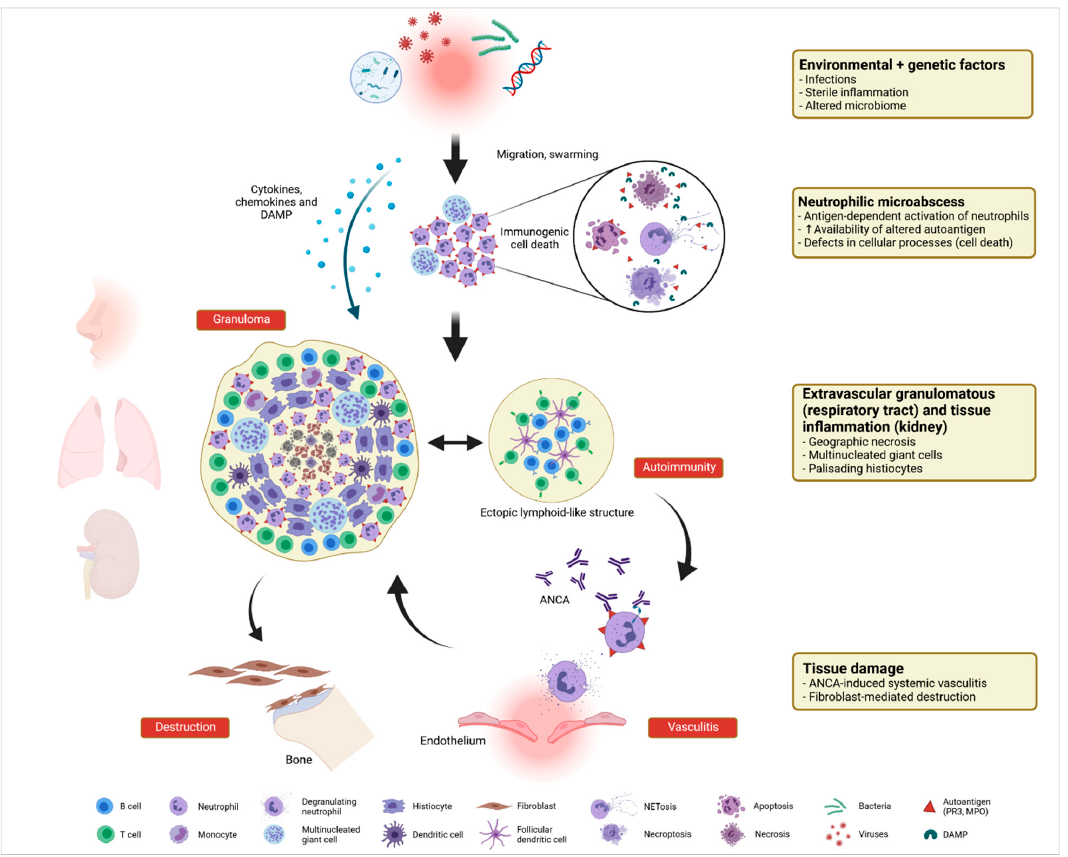
Figure 3. Development and function of the granulomatous inflammation in GPA. A combination of predisposing genetic factors as well as exogenous and endogenous immune-stimulatory patterns such as infections, altered microbiome, and sterile inflammation serve as initial trigger for the recruitment and activation of extravascular primed neutrophils forming neutrophil-rich microabscesses. Appearance of multinucleated giant cells (MGC) in close proximity represents a primary granulomatous feature of this early stage of the granulomatous lesion. Immunogenic cell death (dysregulated apoptosis, necrosis, necroptosis, NETosis) leads to the release of damage-associated molecular patterns (DAMP) and contributes to increased availability of the (altered) autoantigen proteinase 3 (PR3). Concomitant pro-inflammatory cytokines and chemokines drive recruitment of further immune cells, converting the neutrophil-rich necrotizing lesion to a monocyte/macrophage-rich granuloma. Palisading histiocytes around a necrotic zone, accompanied by MGC and the accumulation of monocytes, as well as lymphocytes, define the characteristic histological feature seen in the respiratory tract and the kidney. Occurrence of inflammation-related ectopic lymphoid structures (ELS) set the prerequisite for the loss of tolerance against the autoantigen PR3 that is continuously displayed by high numbers of neutrophils and monocytes within the granulomatous lesion. Tissue damage occurs as result of ANCA-induced systemic vasculitis and inflammation- and fibroblast-mediated local destruction of cartilaginous and osseous tissues in the upper respiratory tract. Created with BioRender.com (accessed on 10 April